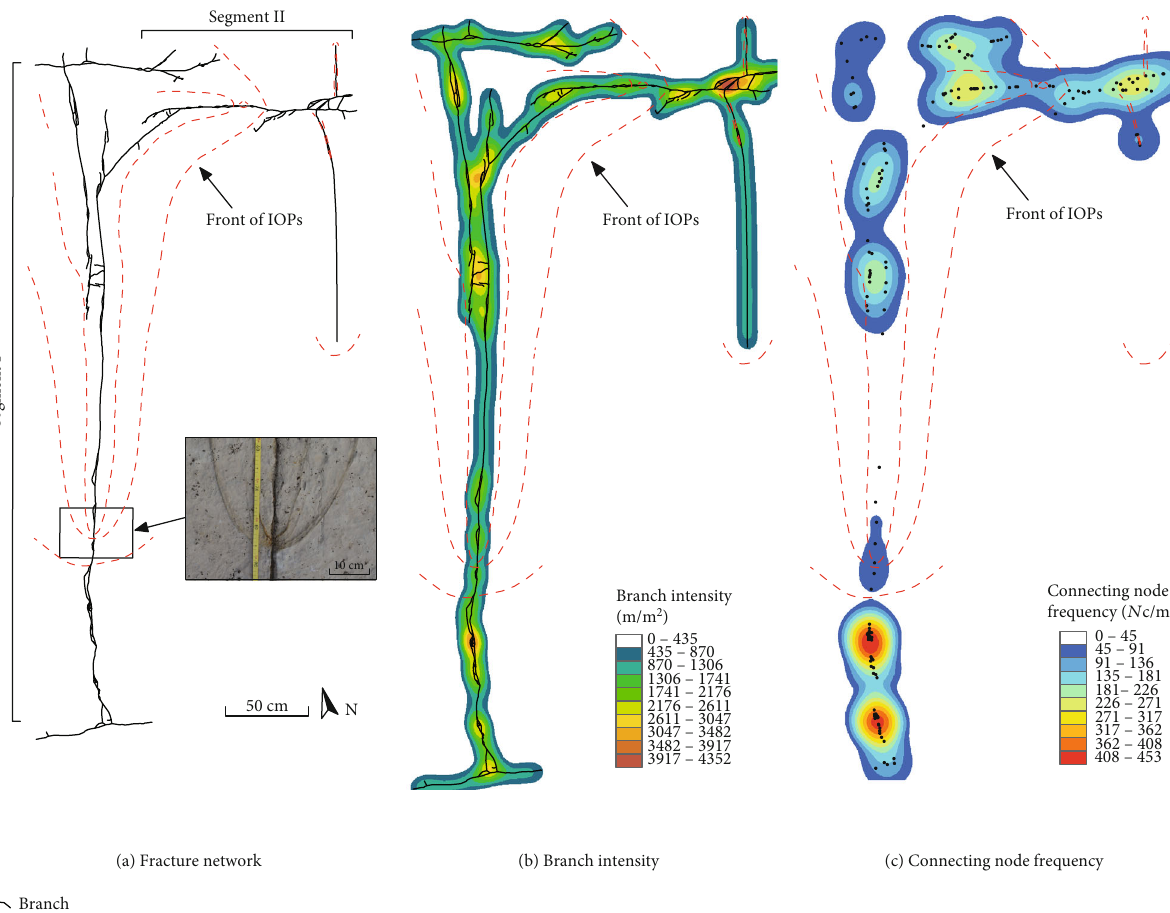
Figure 8: (a) Digitized map of the fracture network at Ras ir Raheb, Malta, with iron oxide precipitates shown as red dashed lines. A photo of a clear front of iron oxide precipitates is included. (b) The branch intensity map indicates higher density in complex zones. (c) Connecting node frequency map of the locality shows that zones with high branch intensity generally tend to coincide with high connecting node